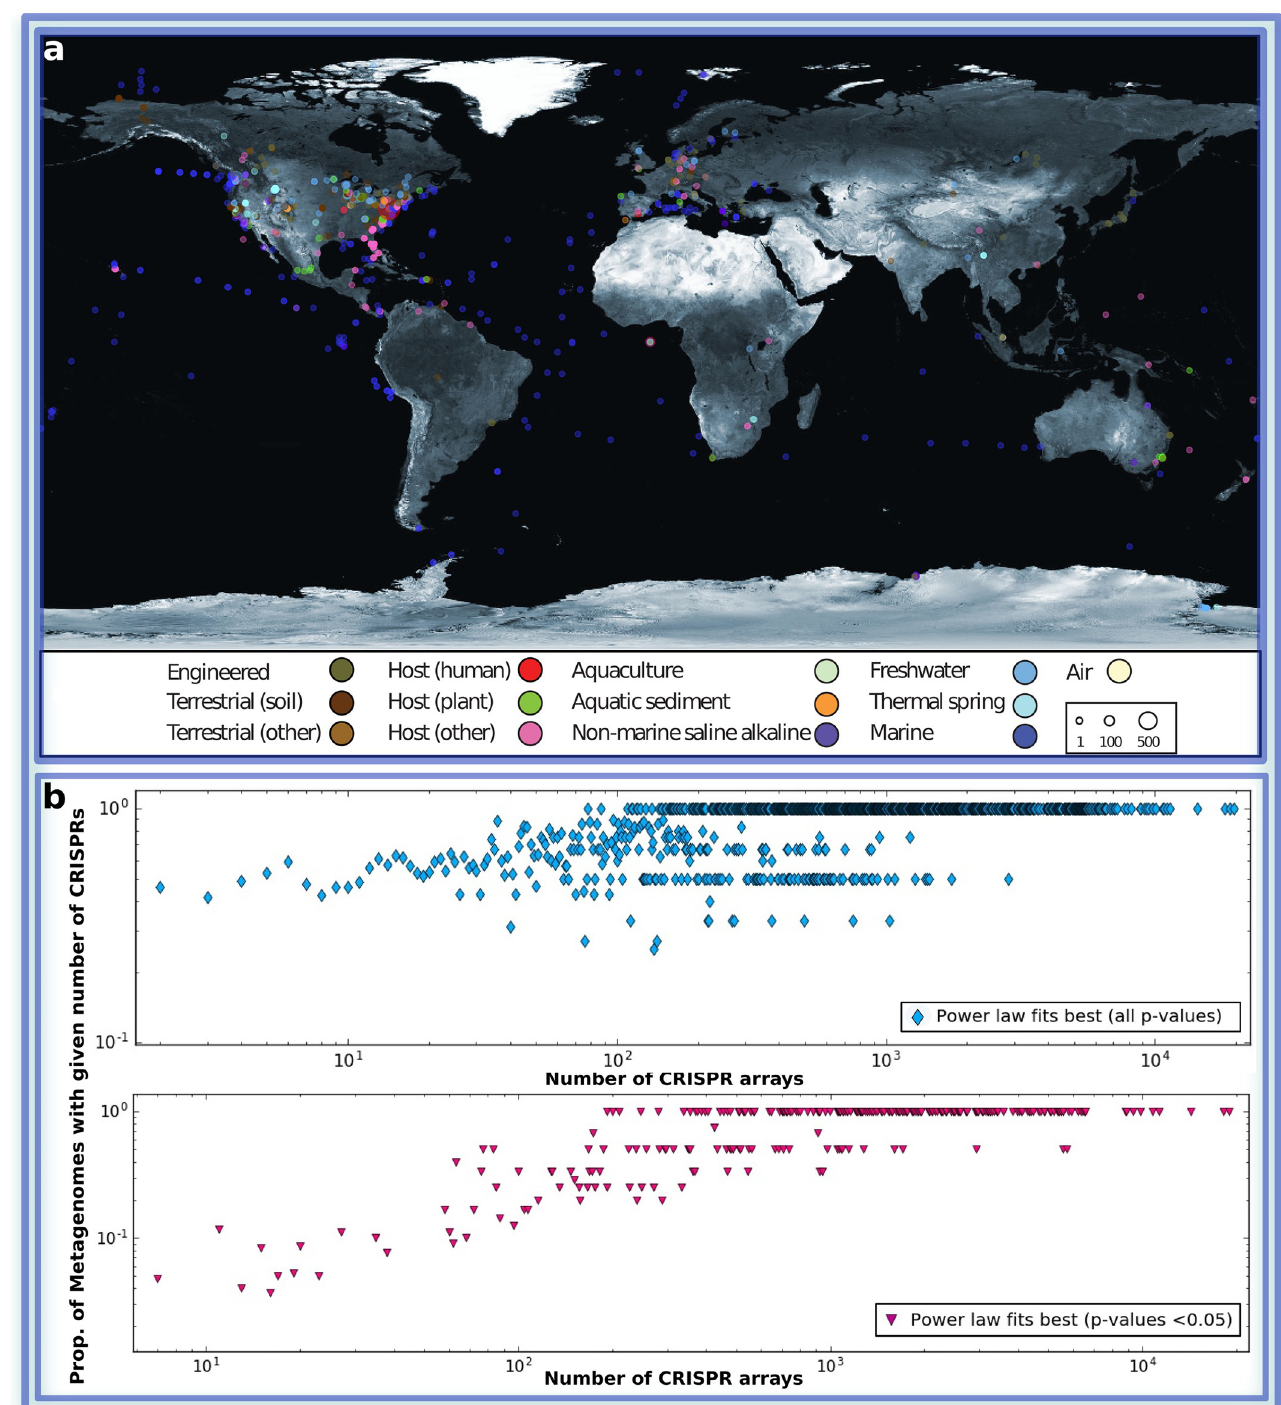
Fig 2. ( a ) World map displaying 3,585 out of 3,858 public metagenomic datasets, for which geographic location is reported, and classified into 13 distinct habitat types (see the color code in the caption) from which we extracted the CRISPR spacer information provided by IMG/M. The total number of samples from a single location is shown with different circle sizes, as indicated in the inset box. For more detail see Table 1 The World map taken from https://visibleearth.nasa.gov/ images/57752. ( b ) The presence of power law distributions of spacers within CRISPR arrays of individual metagenomes. Each point represents all the metagenomes containing a given number of CRISPR arrays. The ordinate value shows the proportion of metagenomes for which either a truncated power law or a non-truncated power law was the best fit.